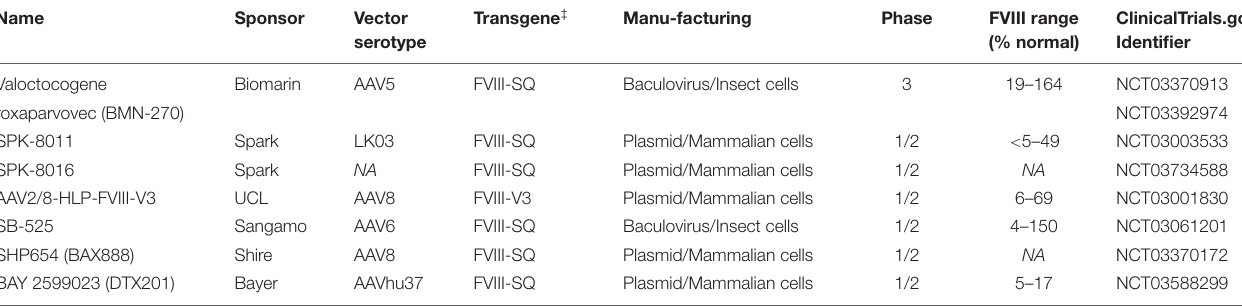
TABLE 1 | Current FVIII AAV liver-directed gene therapy products for HA in clinical